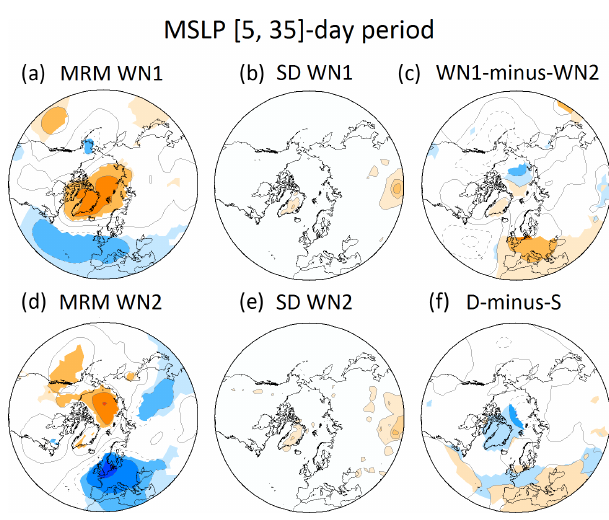
Figure 9. Same as Fig. 7 but for MSLP and the [5, 35]d period after SSWs. Contour interval is 2hPa for MRM composites and dif- ferences and 0.1hPa for the standard deviation of the